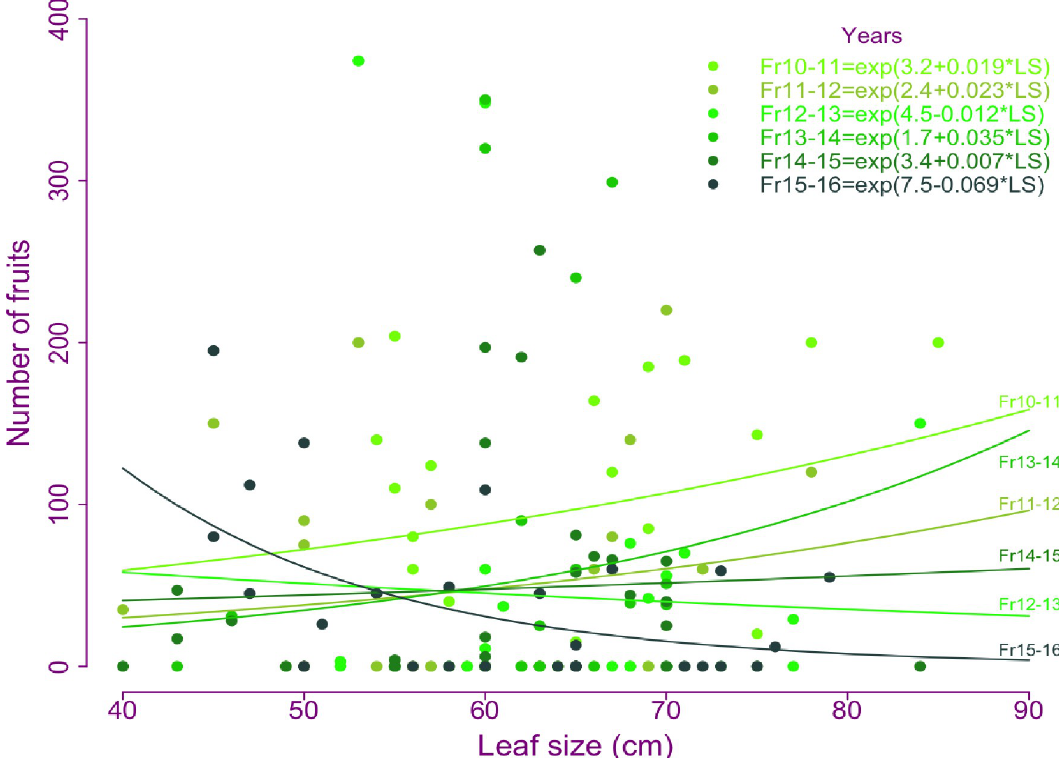
Fig 4. Trade-off between the leaf size and fruit production of Brahea aculeata under different experimental treatments of leaf harvesting in the dry forest of A´lamos, Sonora. The figure shows the coefficients (intercept and slope) indicated by the model for each year. Symbols represent the different years, respectively. The lines in color gradient represents the prediction of the model for each year and are indicated next to the line.